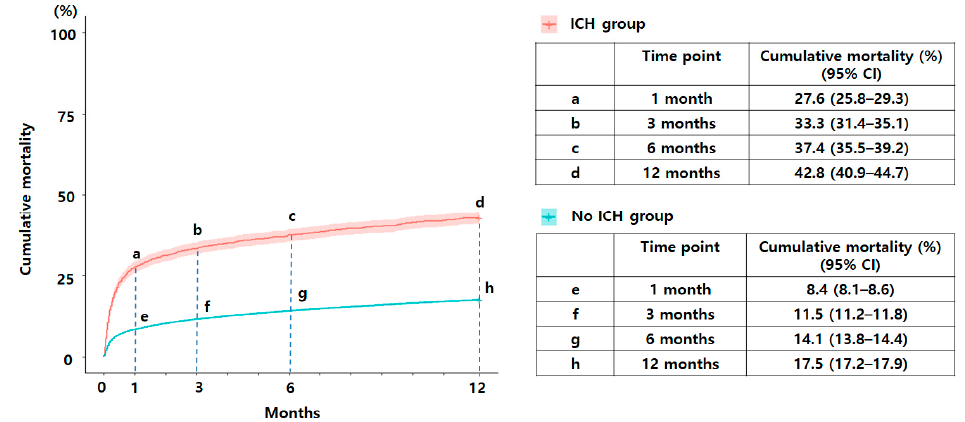
Figure 2. The 1-, 3-, 6-, and 12-month cumulative mortality rates according to the occurrence of Figure 2. The 1 ‐ , 3 ‐ , 6 ‐ , and 12 ‐ month cumulative mortality rates according to the occurrence of spontaneous intracerebral hemorrhage. spontaneous intracerebral hemorrhage.